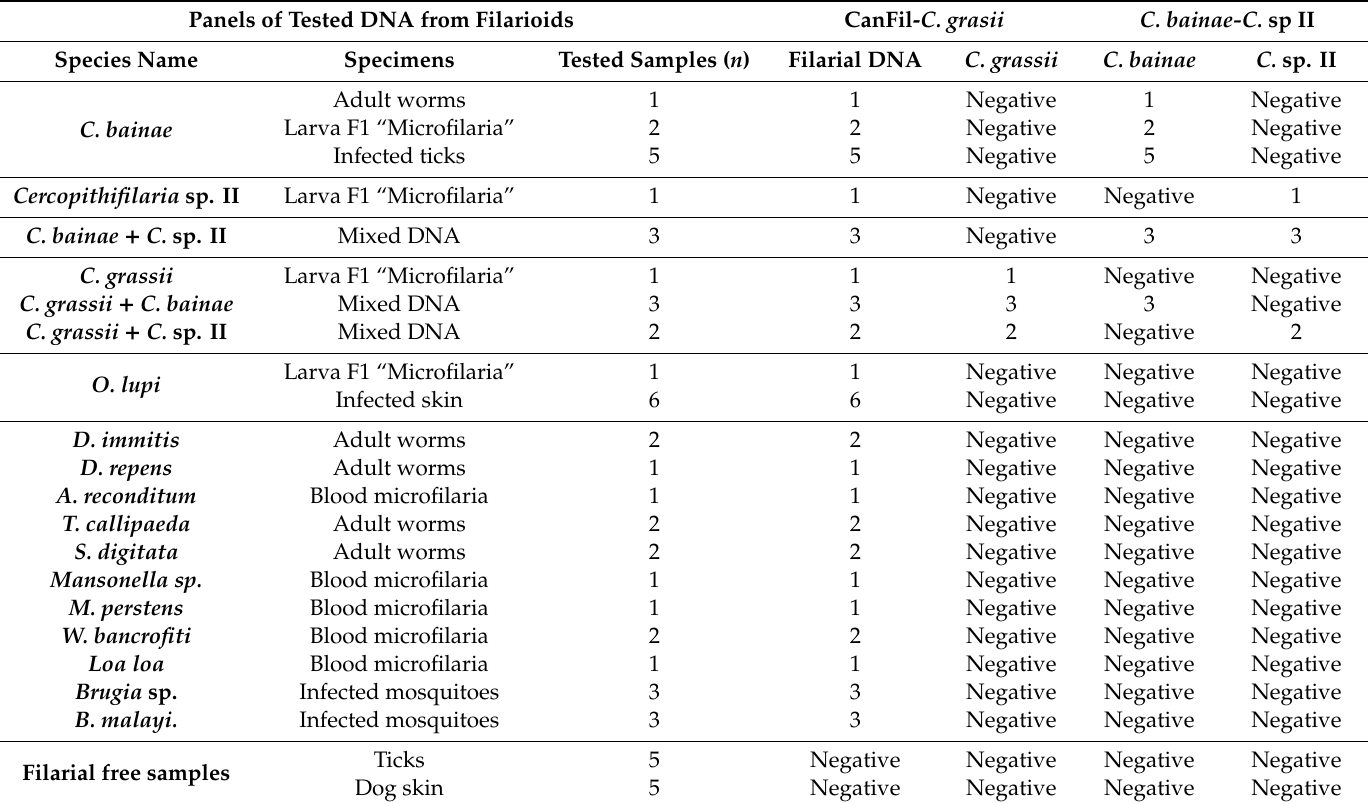
Table 2. In-vitro validation of the newly customized duplex qPCRs trough the DNA panel of filarioids and negative hosts (dogs and ticks). Panels of Tested DNA from